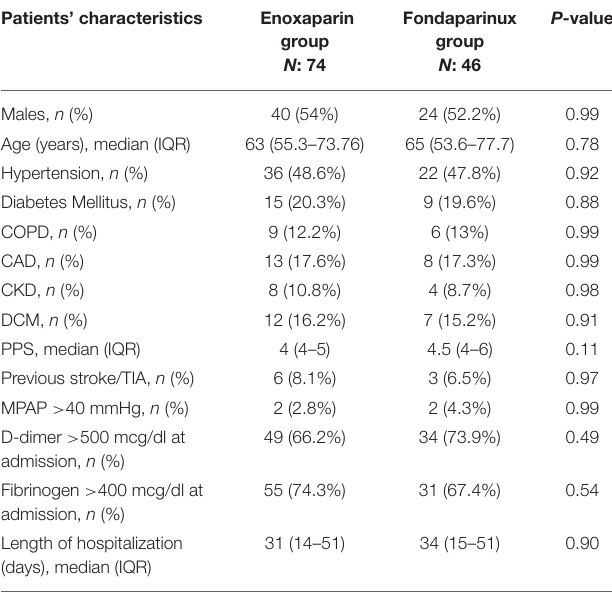
TABLE 1 | Demographic and laboratory and clinical characteristics of the study population. Patients’